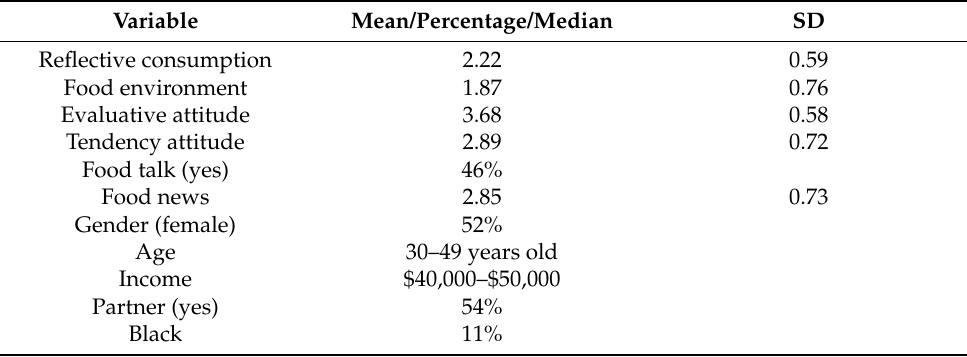
Table 1. Descriptive